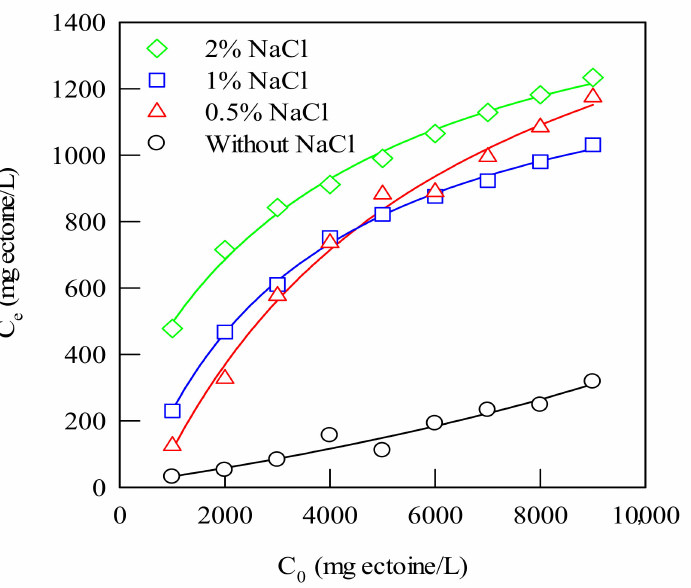
Figure 8. Effect of salt on adsorption of ectoine using a cation-exchange resin (Dowex ® HCR-S = 1 g, initial ectoine = 1000 − 9000 mg/L, aqueous solution = 10